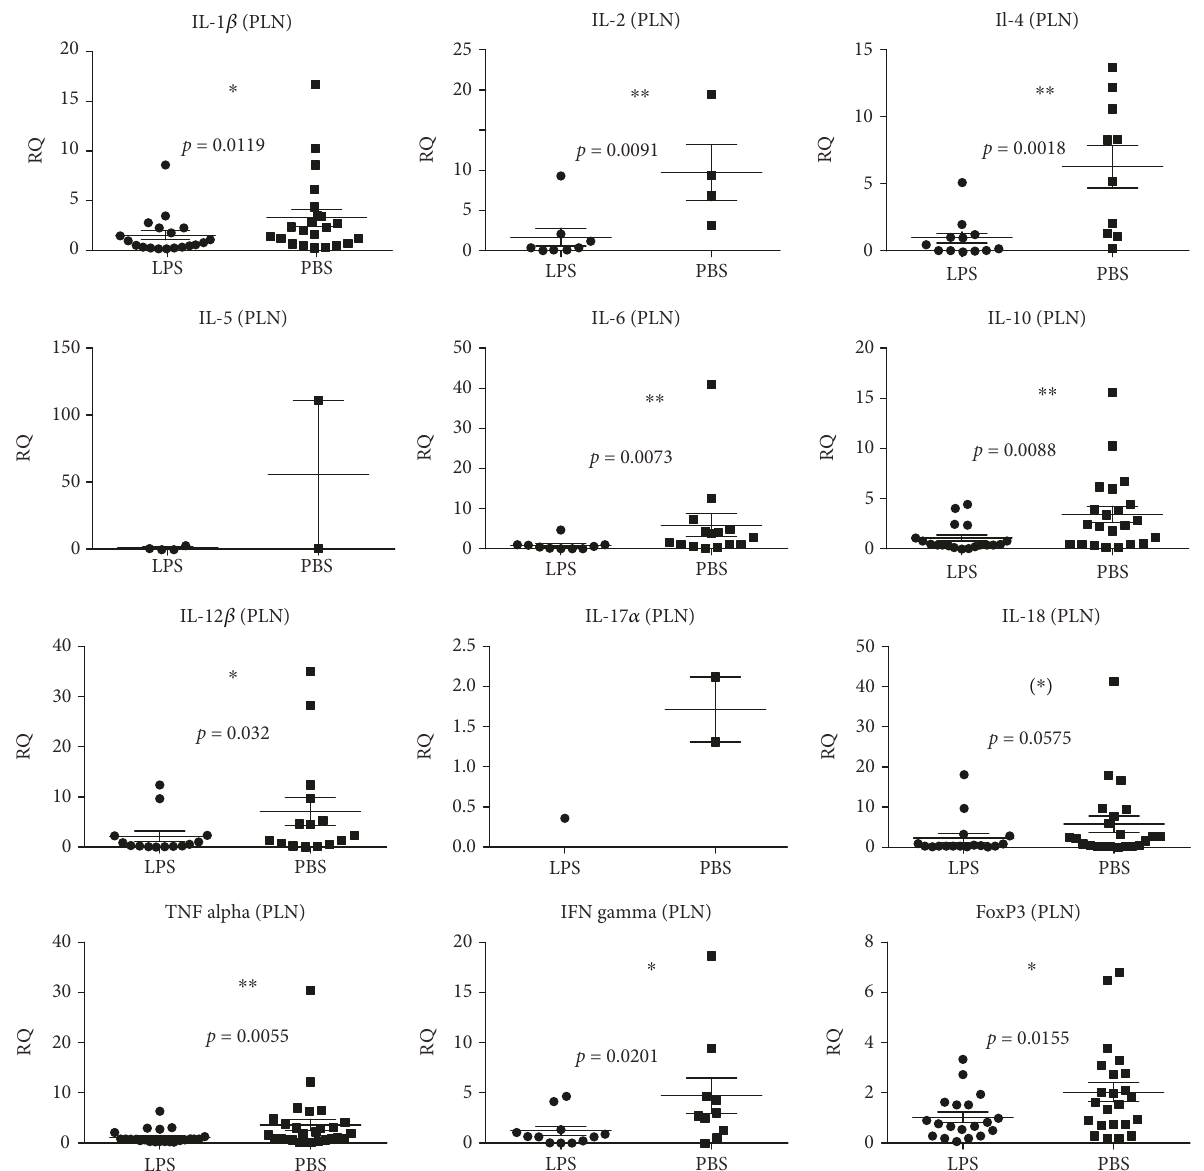
Figure 1: Cytokine and regulatory T cell ( FoxP3 ) gene expressions in the pancreatic lymph nodes (PLN) of 40 (18 female and 22 male) four-week-old C57BL/6NTac mice given either LPS ( n = 18 ) or PBS ( n = 22 ) orally daily from birth until weaning at four weeks of age. Mean and SD are shown. ∗ p < 0 05 ; ∗∗ p < 0 01 ; ∗ tendency p = 0 05 – 0 1